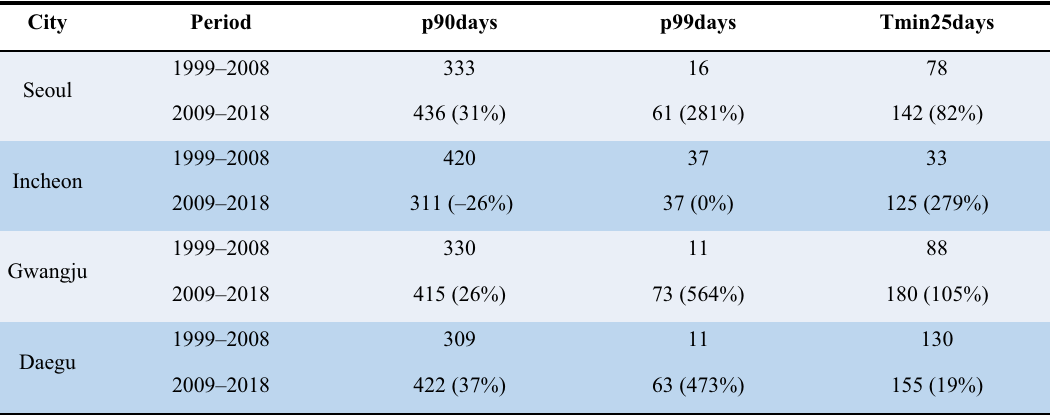
Table 4. The number of days that exceed Tmax and Tmin thresholds, where ( ) indicates % change between decades. p90dyas: number of days when the Tmax is above 90 percentile of Tmax (1999–2018). p99dyas: number of days when the Tmax is above 99 percentile of Tmax (1999–2018). Tmin25days: number of days when the temperature does not fall under 25 °C during the day.